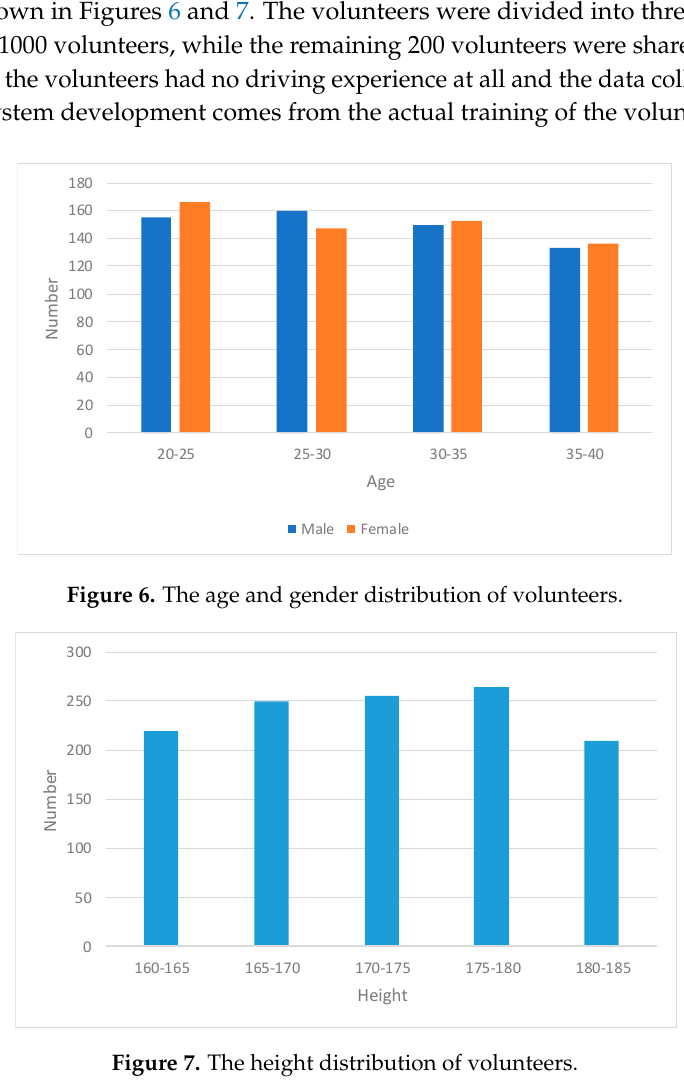
Figure 7. The height distribution of volunteers.